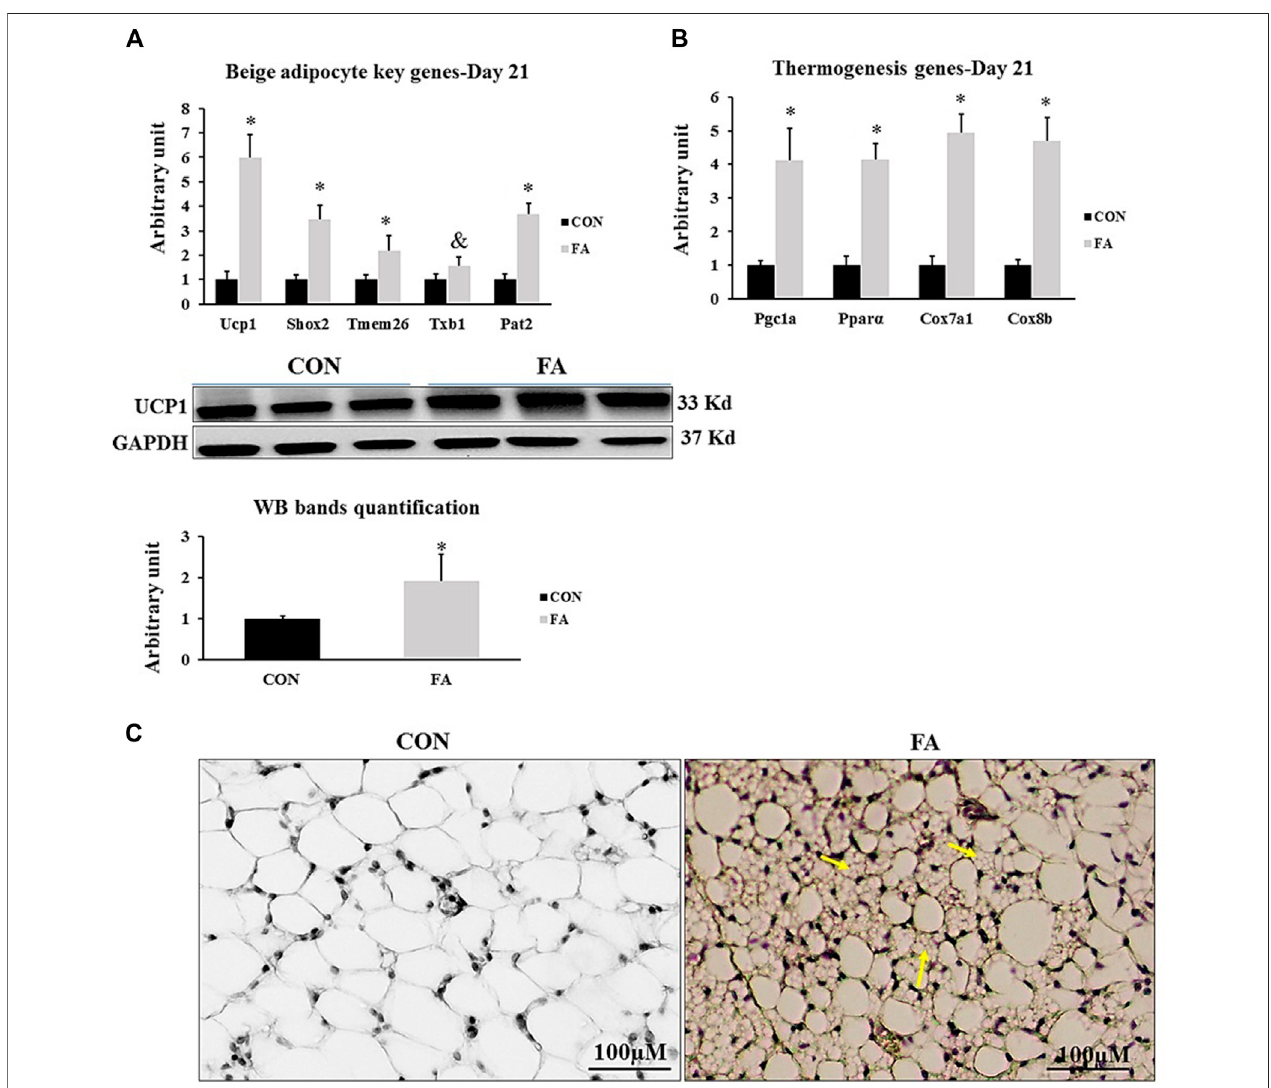
FIGURE12| EffectofmaternalintakeofEPA/DHAonpotentialbrowningofsubcutaneousfatinweanedmice(D21).Themotherswerefedeithercontroldiet(CON) orEPA/DHAenriched diet(FA)duringtheentireperiod ofpregnancyandlactation (A) QuantitativeRT-qPCR( n =8)andrepresentativeimageanddensitometric analysis of western blot ( n = 4) genes regulating beige adipocytes development in sub-cutaneous fat of weaned mice, 3 weeks postpartum (B) The relative expression ( n = 8) of genes involved in regulating the thermogenesis process in weaned mice, 3 weeks postpartum. All the raw Cts was normalized to the value of 18 s. Data